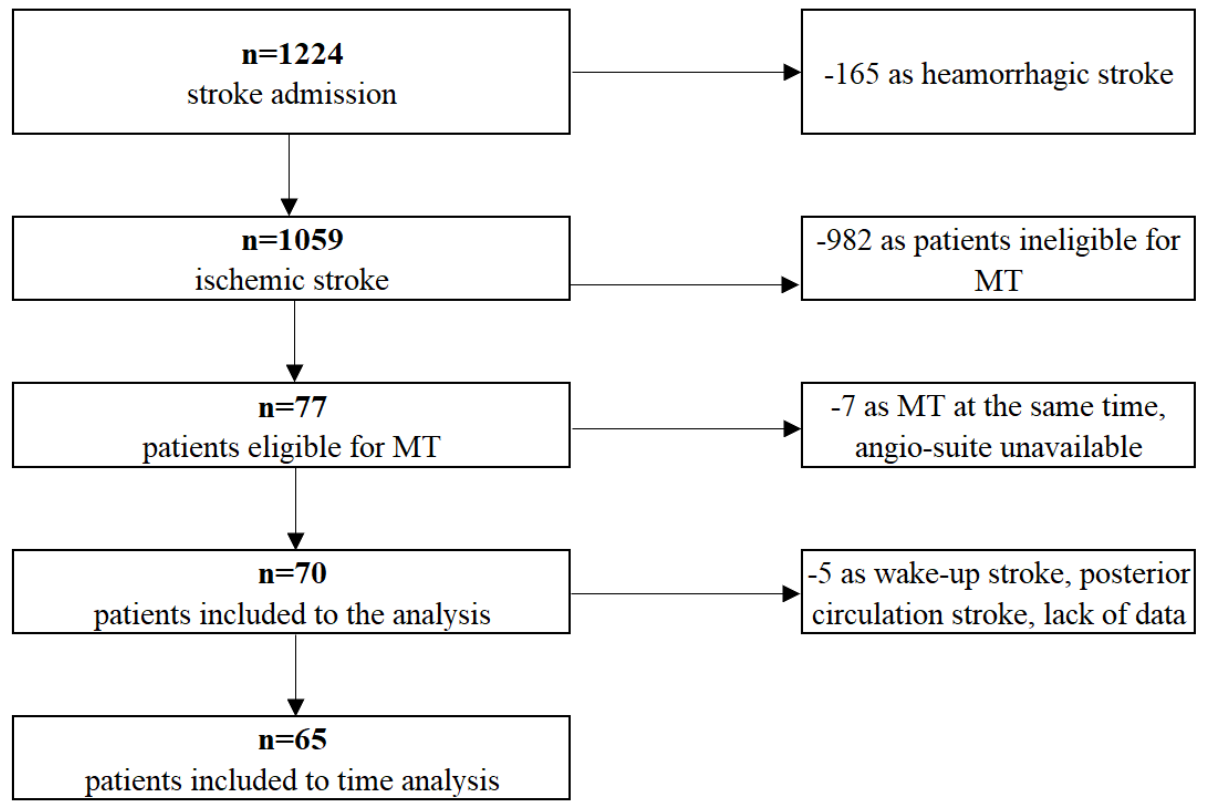
Figure 1. Our group of patients flow chart. Table 1. Baseline clinical patient characteristics of both groups (mean age, men, women, hypertension, diabetes mellitus, atrial fibrillation, known history of smoking, baseline NIHSS, occlusion location, IV thrombolysis). Data are presented as mean ± SD/N or %